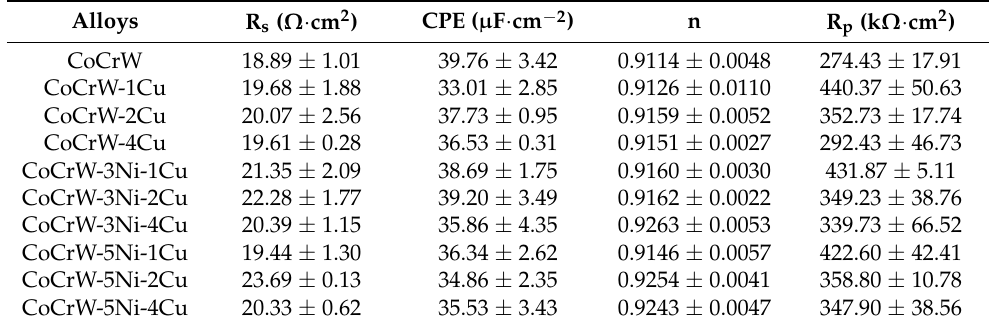
Table 5. Electrochemical data obtained from EIS curves after fitting using ZsimpWin software.